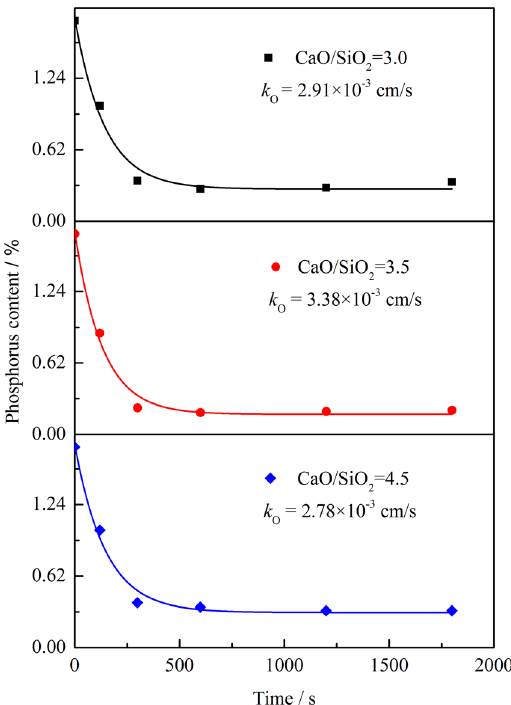
Figure 4: Variation of the P content as a function of time with the basicity ranging from 3.0 to 4.5.